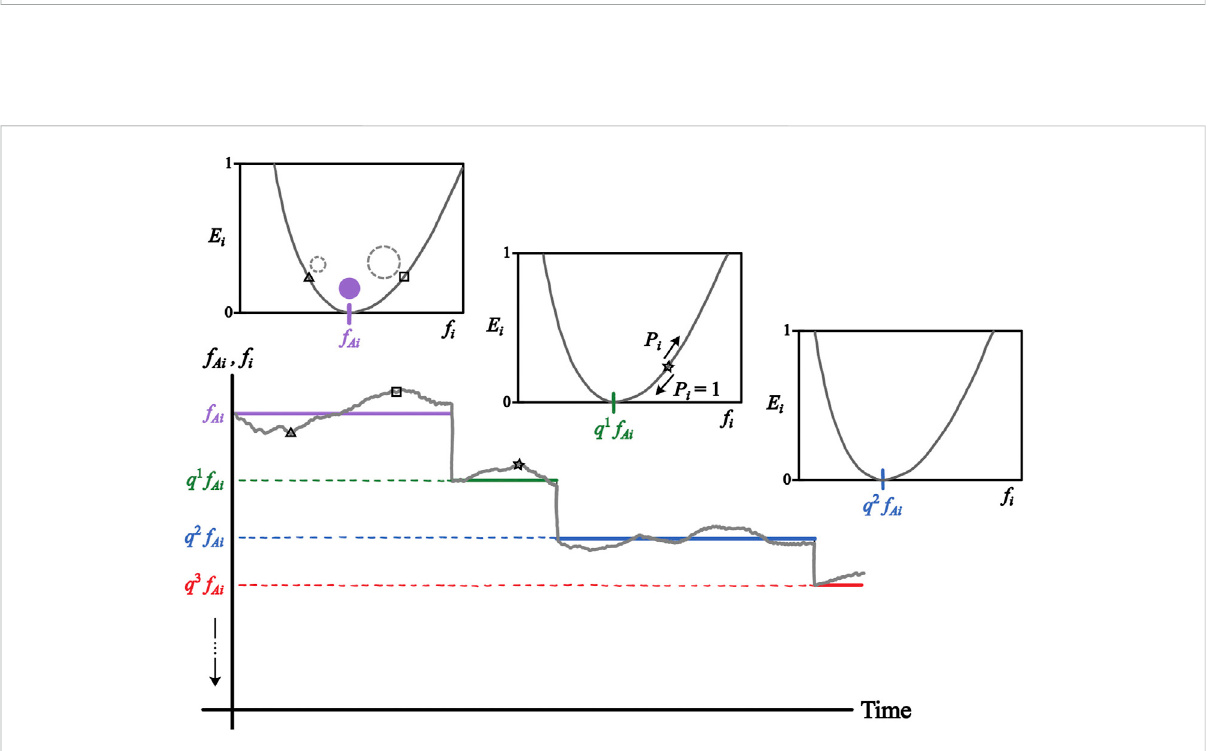
FIGURE 5 Representation of unratcheted and ratcheted constriction processes in the enhanced AGF model. The unratcheted constrictions are modeled asuncorrelatedrandom fl uctuationsoftheactualconstrictionfactor f i ,Eq.6,(grayline)aroundthecurrentanchorvalue f A i ,Eq.7,(purple,green,and blue lines). The unratcheted constrictions are modeled as MCMC generated from the Metropolis potential E i with the minimum at f A i (insets); the ratcheted constrictions are represented by a unidirectional, stress-correlated stepwise process resulting in adecrease of f A i by aratio q = 0.9 in eachstep.Leftinsetshowsthattheactualinteractionrangeofaforcecentercanbelargerorsmallerthantheanchorsize.Middleinsetindicatesthat thedecreaseorincreaseof f i inagivensimulationstepisacceptedwiththeprobability P i thatdependson E i ,asde fi nedbyEq.9.Allthreeinsetsshow that ratcheted constrictions result in a shift of the Metropolis potential towards the smaller values of f i